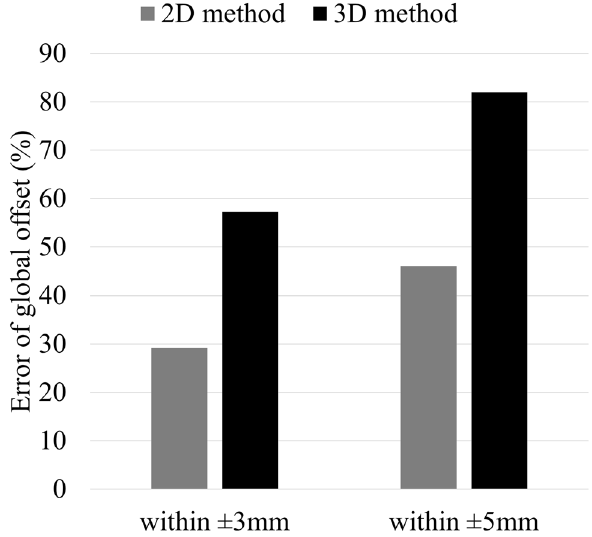
Figure 5. Comparison of 2D and 3D methods for error of global offset between native and implanted